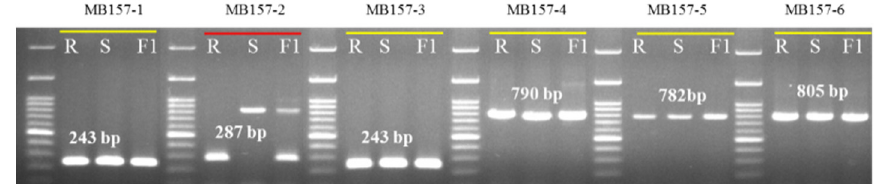
Figure 3. Banding patterns of six pairs of primers designed against the gene MELO3C022157. Polymorphic primer MB157-2 is marked with red underline. R—resistant parent PI 353814, S— susceptible parent PI 614596 and F1—their F 1 hybrid. Primer details are given in Table 3.